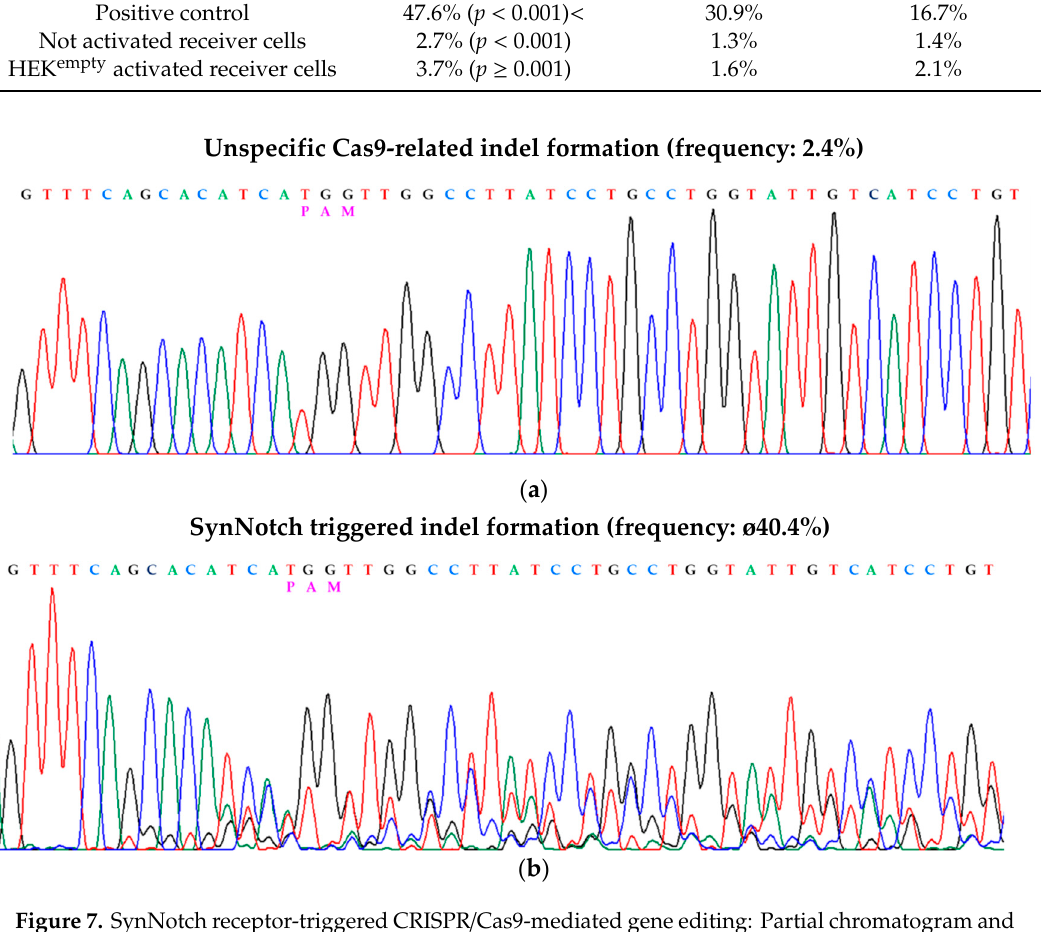
Figure 7. SynNotch receptor-triggered CRISPR/Cas9-mediated gene editing: Partial chromatogram and TIDE-based indel quantification of synNotch receptor–triggered CRISPR/Cas9-mediated gene editing in inactivated HEK293 receiver cells ( a ) and synNotch receptor-triggered CRISPR/Cas9-mediated gene editing in activated HEK293 receiver cells ( b ).